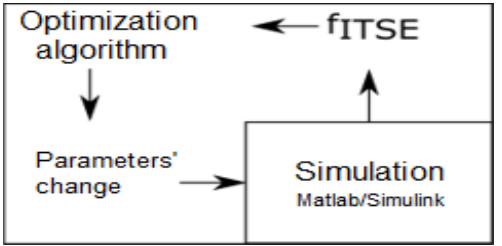
Figure 10. Tuning of controllers’ parameters.